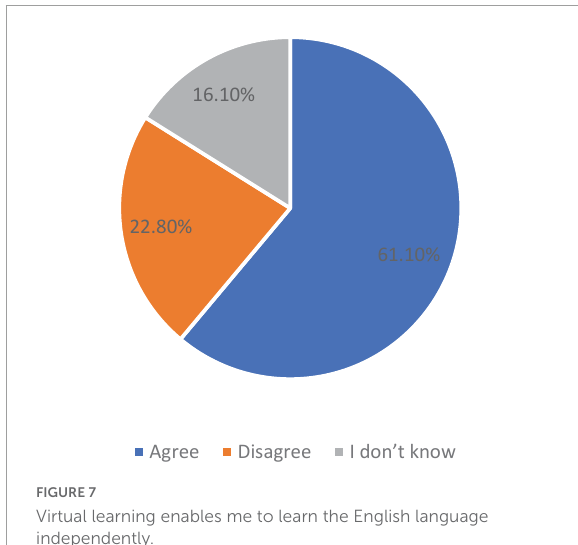
any opinion. They were unsure whether it was possible for anyone to learn English virtually.